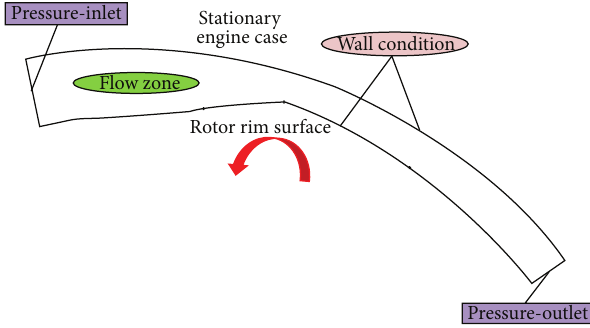
Figure 3: Specific boundary conditions of Rampressor inlet.